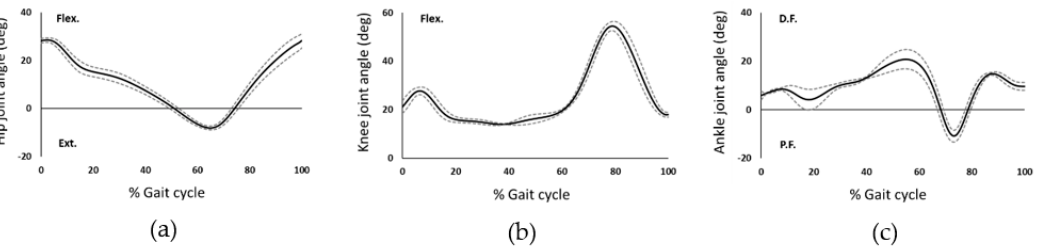
Figure 10. Joint angles of the ( a ) hip, ( b ) knee, and ( c ) ankle in the intact legs. The solid and dashed lines indicate the mean values and standard deviations, respectively. Positive angles indicate hip extension (Ext.), knee flexion (Flex.), and ankle dorsal flexion (D.F.).